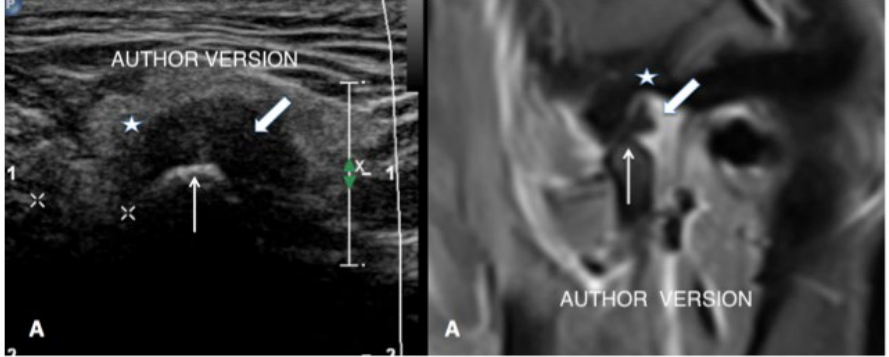
Figure 3. View of exudate causing increased width of the temporomandibular joint gap on ultrasound examination and MRI (star-glenoid fossa, thick arrow-disc, thin arrow-mandible condylar head.